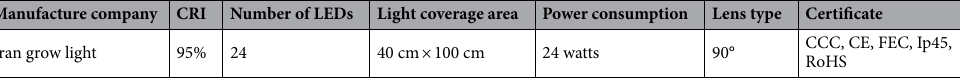
Table 2. Characteristics of LEDs used in this